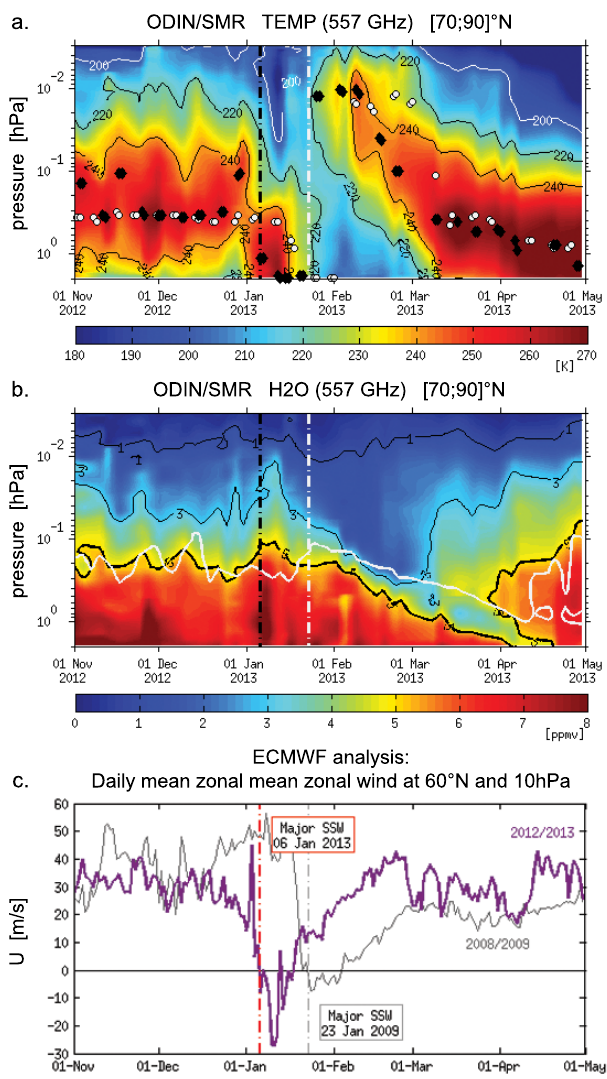
Figure 1. (a) Upper stratosphere/mesosphere pressure–time section of SMR zonal mean temperature in the 70–90 ◦ latitude band during the Arctic winter 2012/2013. Black diamonds indicate the zonal av- erage stratopause height, and the black dash-dotted line indicates the central date of the warming. For comparison, overlaid white dots and white dash-dotted line correspond to the same parameters for the 2009 event. (b) Same as (a) but for SMR zonal mean H 2 O volume mixing ratio. The thick black contour is associated with vol- ume mixing ratio values of 5ppmv. The same contour measured in 2008/2009 (solid white line) is overlaid for comparison. (c) Daily mean zonal mean zonal wind at 60 ◦ N and 10hPa from ECMWF analyses during the Arctic winters 2008/2009 (thin grey line) and 2012/2013 (thick purple line). The dash-dotted lines indicate the central dates of these